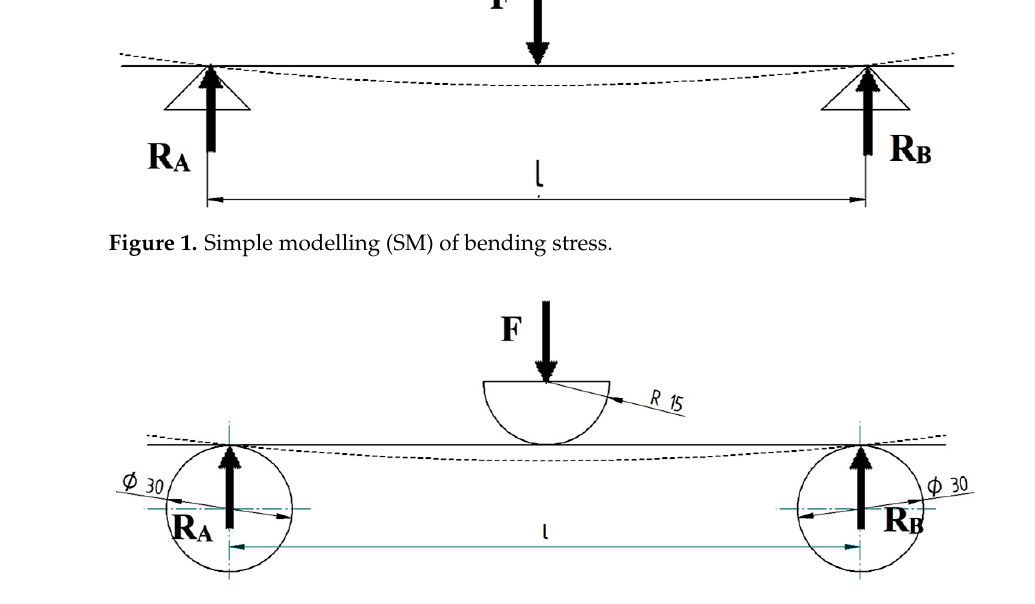
Figure 2. Complex modelling (CM) of bending stress.